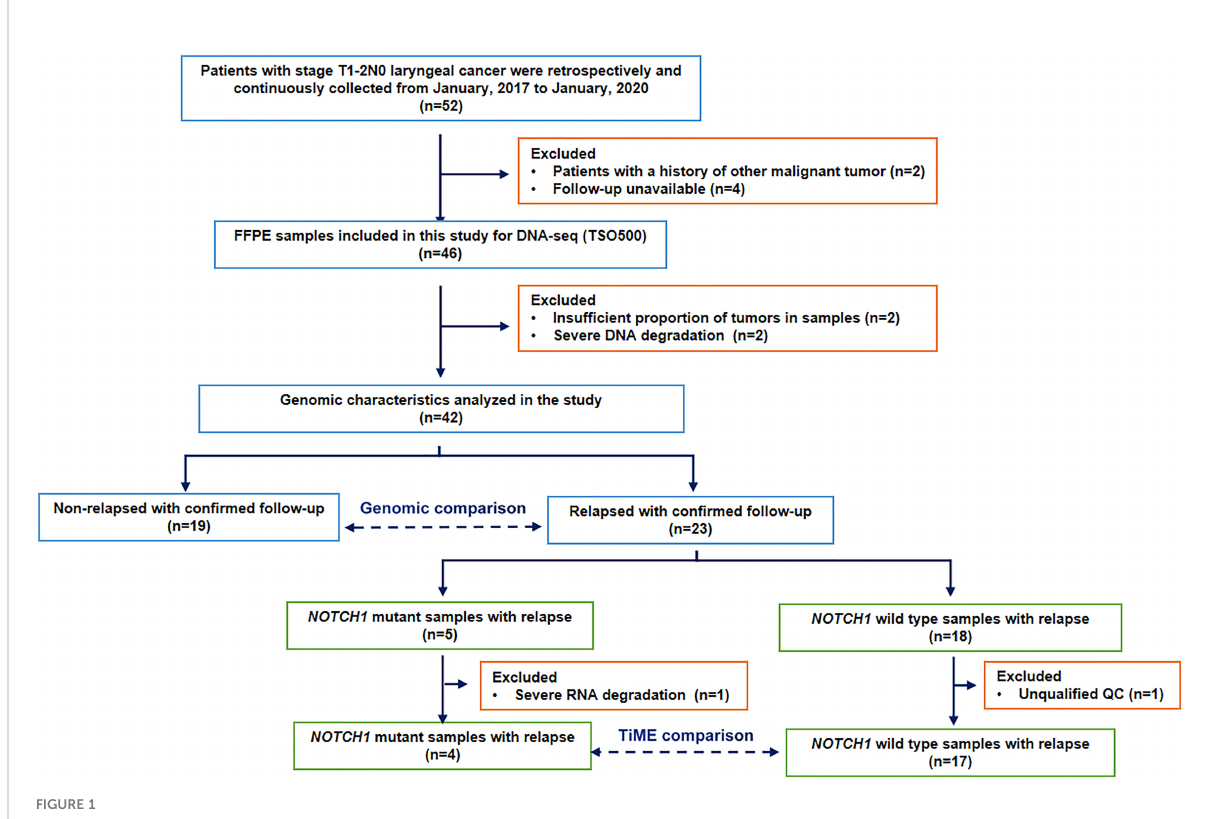
FIGURE 1 Flowchart of patient